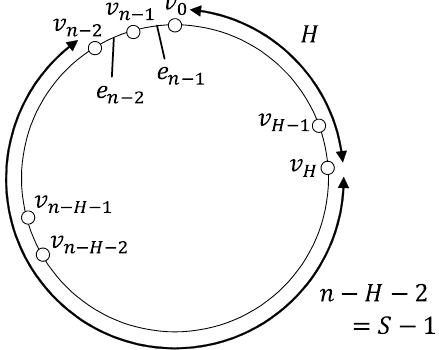
Figure 1. Illustrating the proof of Theorem 1 for the case of H + S < n and S ≥ (cid:100) n /2 (cid:101)